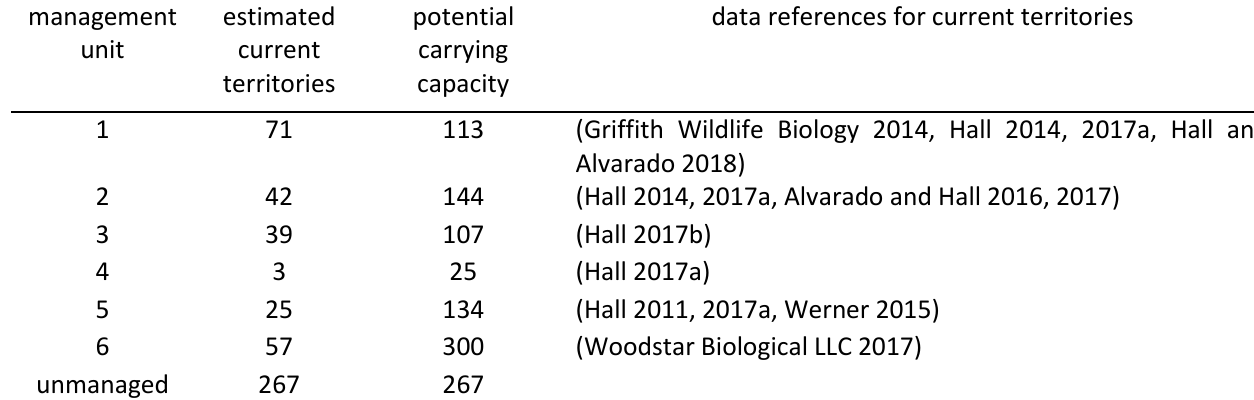
Table A1.1. Estimated number of current territories of Least Bell’s Vireo and future potential carrying capacity (as number of breeding pairs) if land within management units with potential to be suitable for vireo nesting was actively and successfully